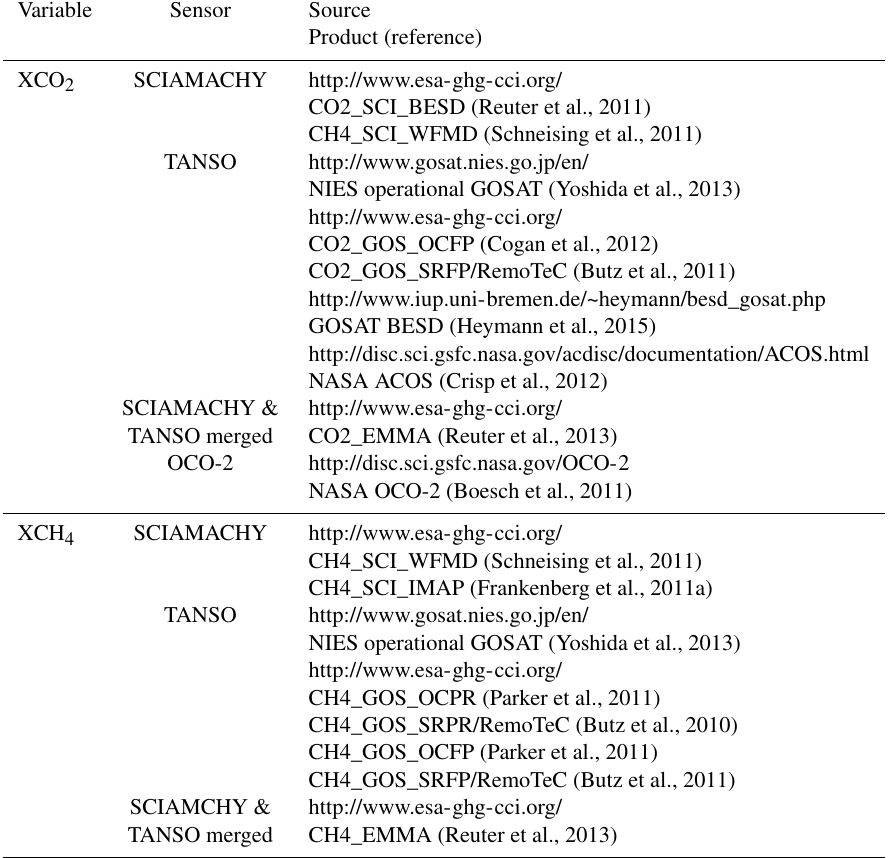
Table 1. Overview of SCIAMACHY/ENVISAT and TANSO-FTS/GOSAT XCO 2 and XCH 4 level 2 data products (individual ground-pixel retrievals). For some products, level 3 (i.e. gridded data) products are also available (e.g. for CO2_SCI_WFMD and CH4_SCI_WFMD